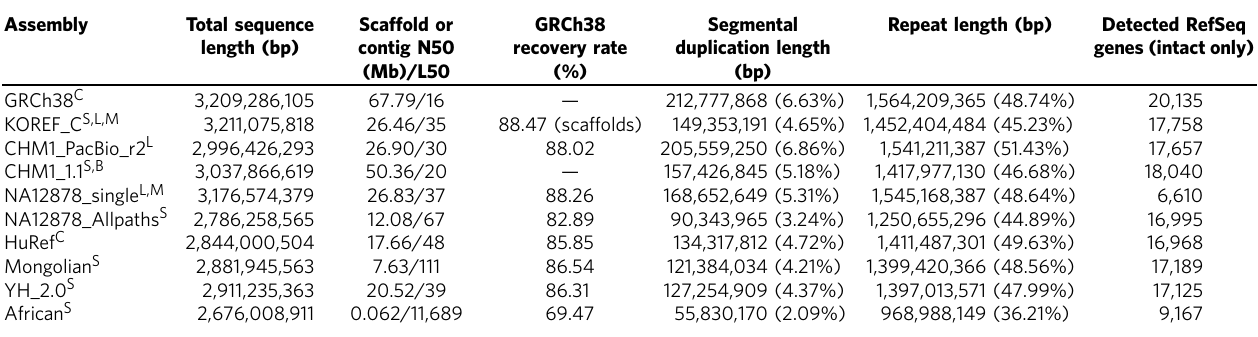
Table 2 | Systematic comparison of assembly quality.